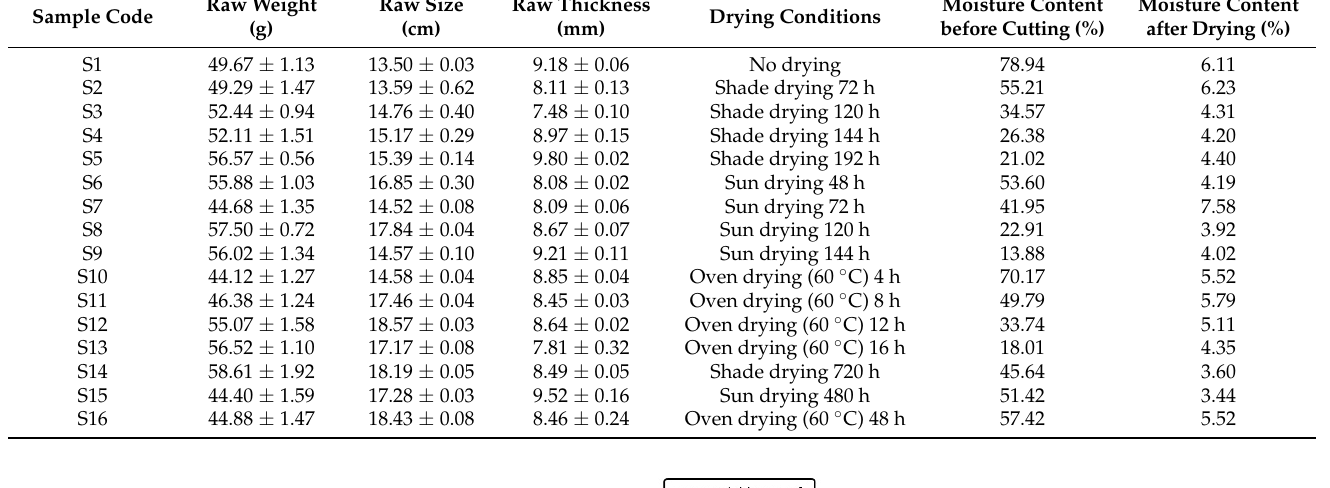
Table 2. Different processing treatment methods.